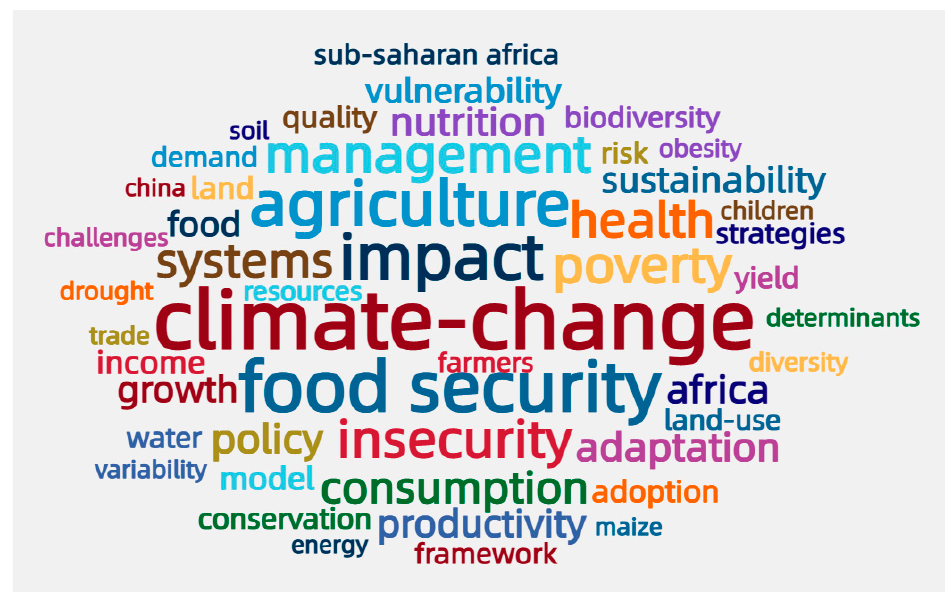
Figure 6. High-frequency keywords in the field of food security (top 50 keywords).